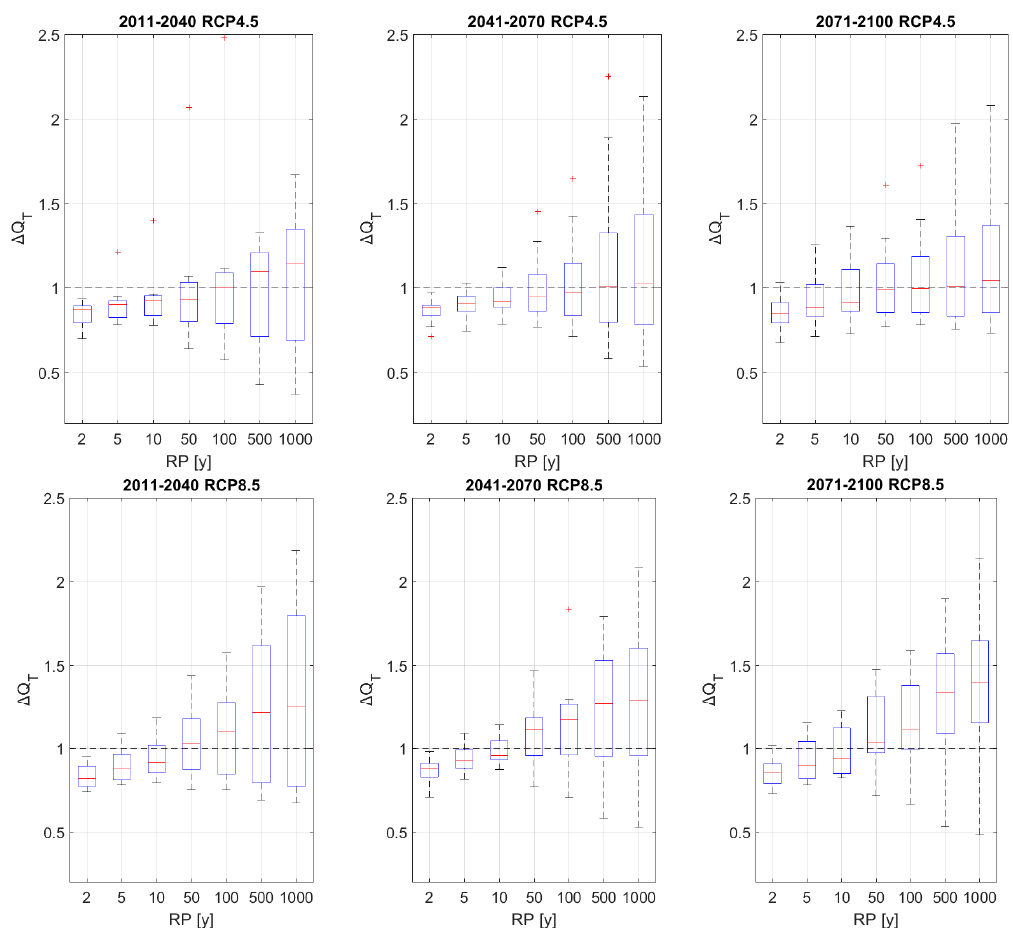
Figure 8. Boxplots of Δ Q T values for the 12 climate models considered in the study. The upper row shows the results for the RCP 4.5 and the lower row for the RCP 8.5. The first column shows the results for the 2011–2040 period, the second for